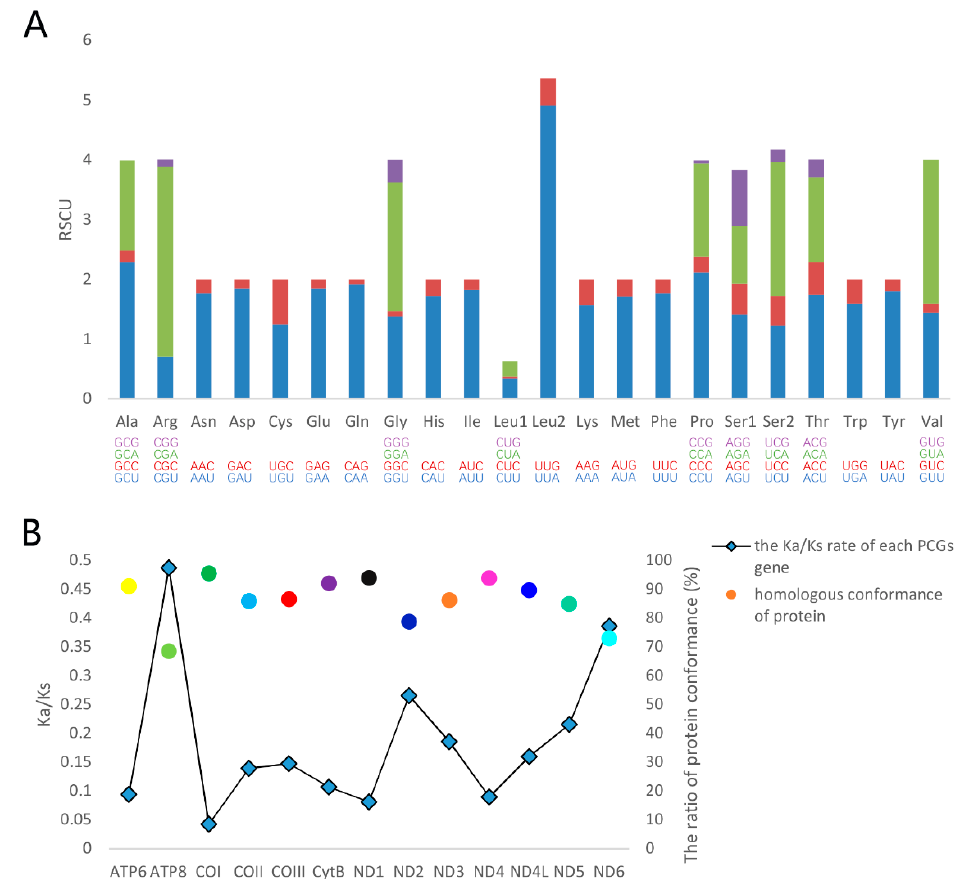
Figure 3. Analyses of protein-coding genes (PCGs) in H.sinicus . ( A ) Relative synonymous codon usage (RSCU) of 13 PCGs. ( B ) Protein conformance and evolutionary dynamics of 13 PCGs, Damaster mirabilissimus mirabilissim (GQ344500) is used as the reference.